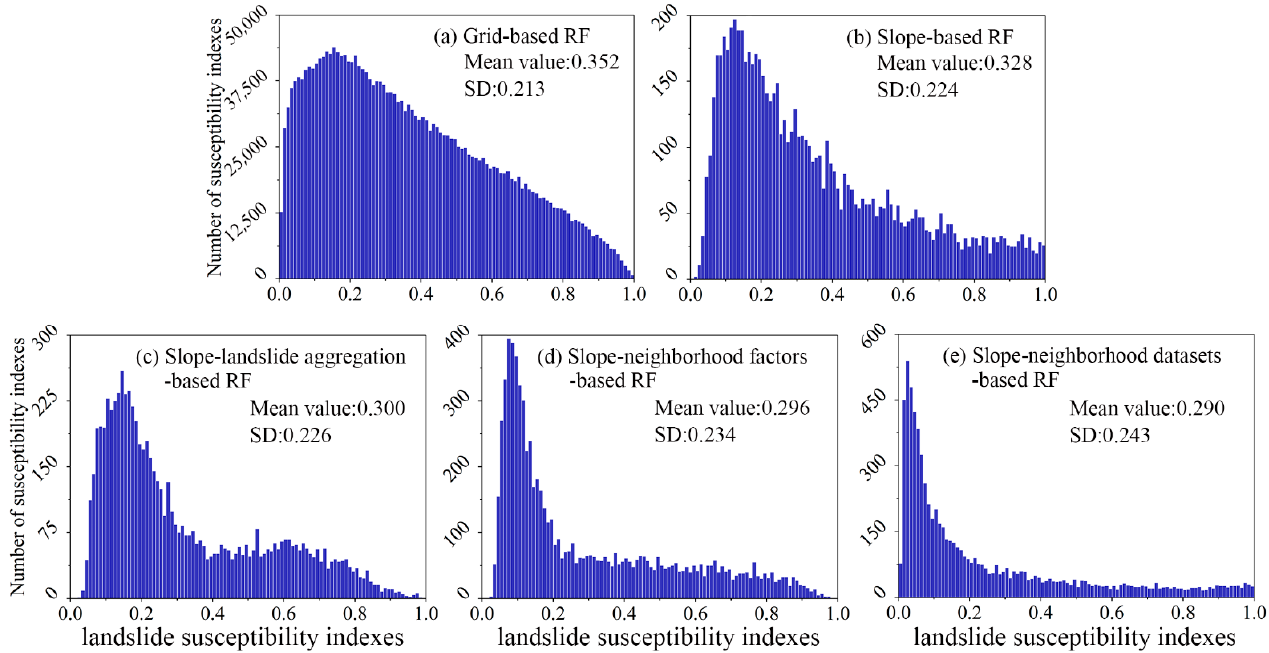
Figure 10. Distribution patterns of LSIs based on the RF model. ( a ) Grid-based RF; ( b ) Slope-based RF; ( c ) Slope–landslide aggregation-based RF; ( d ) Slope–neighborhood factors-based RF; ( e ) Slope– neighborhood datasets-based RF.